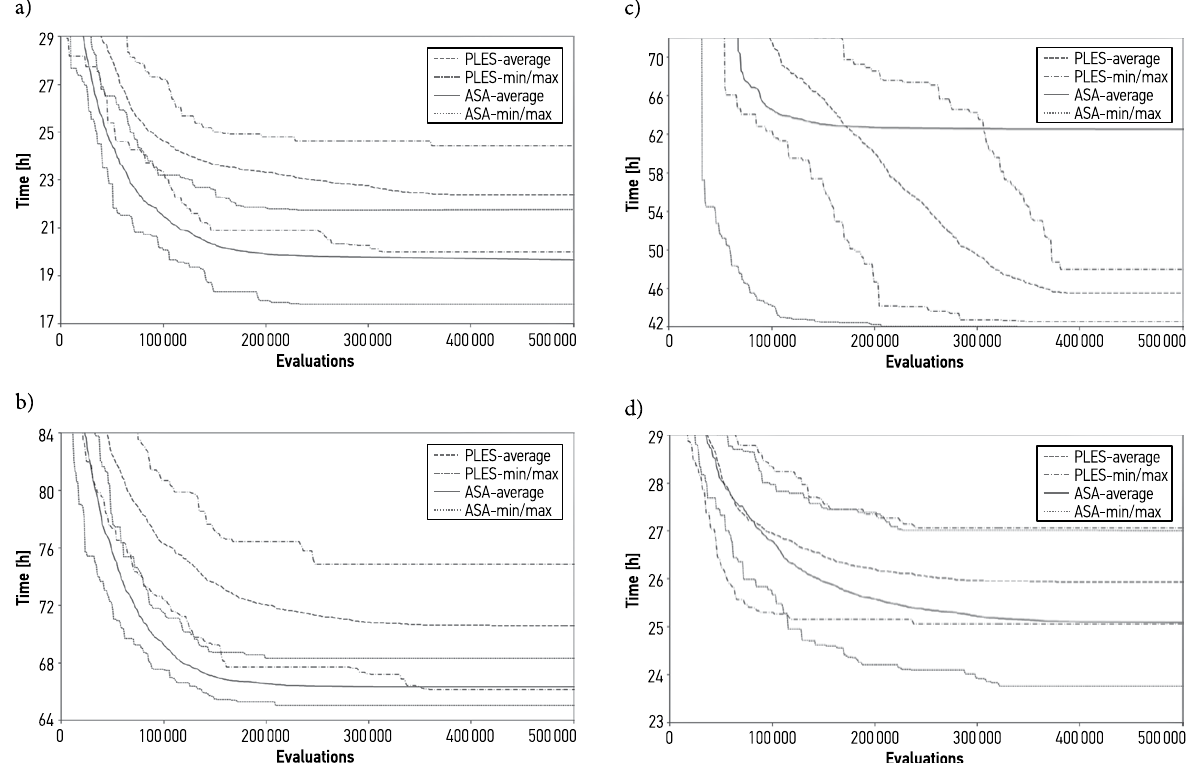
Fig. 6. Performance of the PLES and the ASA for free transportation in: a – Task 1; b – Task 2; c – Task 3; d – Task